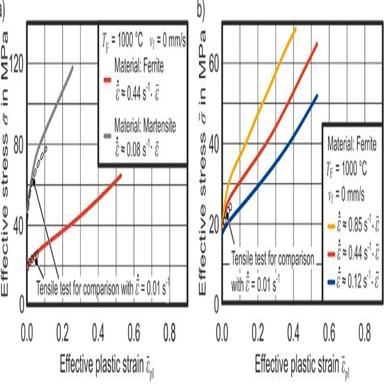
Flow curves determined by the hot-tube-bulge test for a) both tubular materials with specific strain rates ˙ ε and b) ferritic tubular material with different pressure load ramps p ˙ and resulting rates ˙ ε.